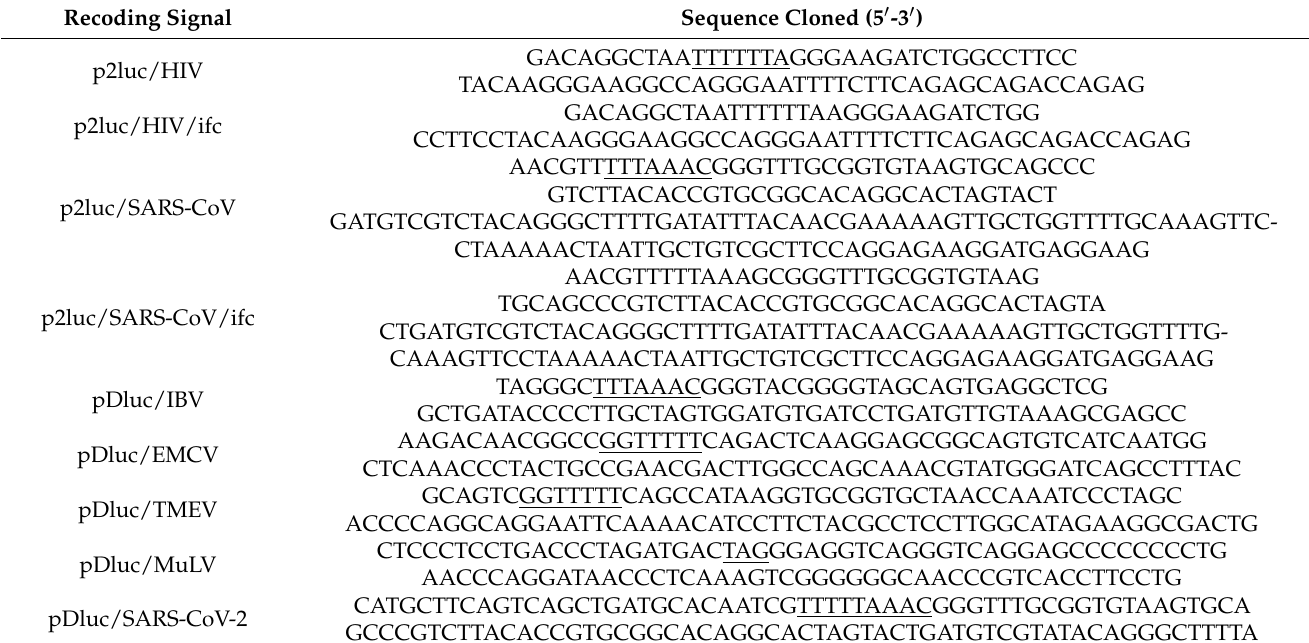
Table 1. Sequences of recoding signals employed (recoding site